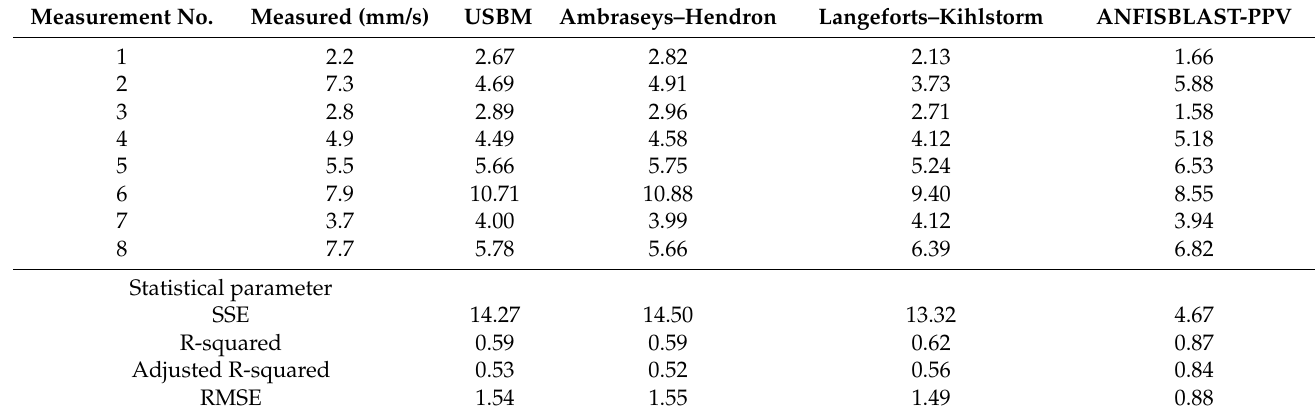
Table 9. Measure of performance for the adaptive network-based fuzzy inference system (ANFIS) and conventional predictors.